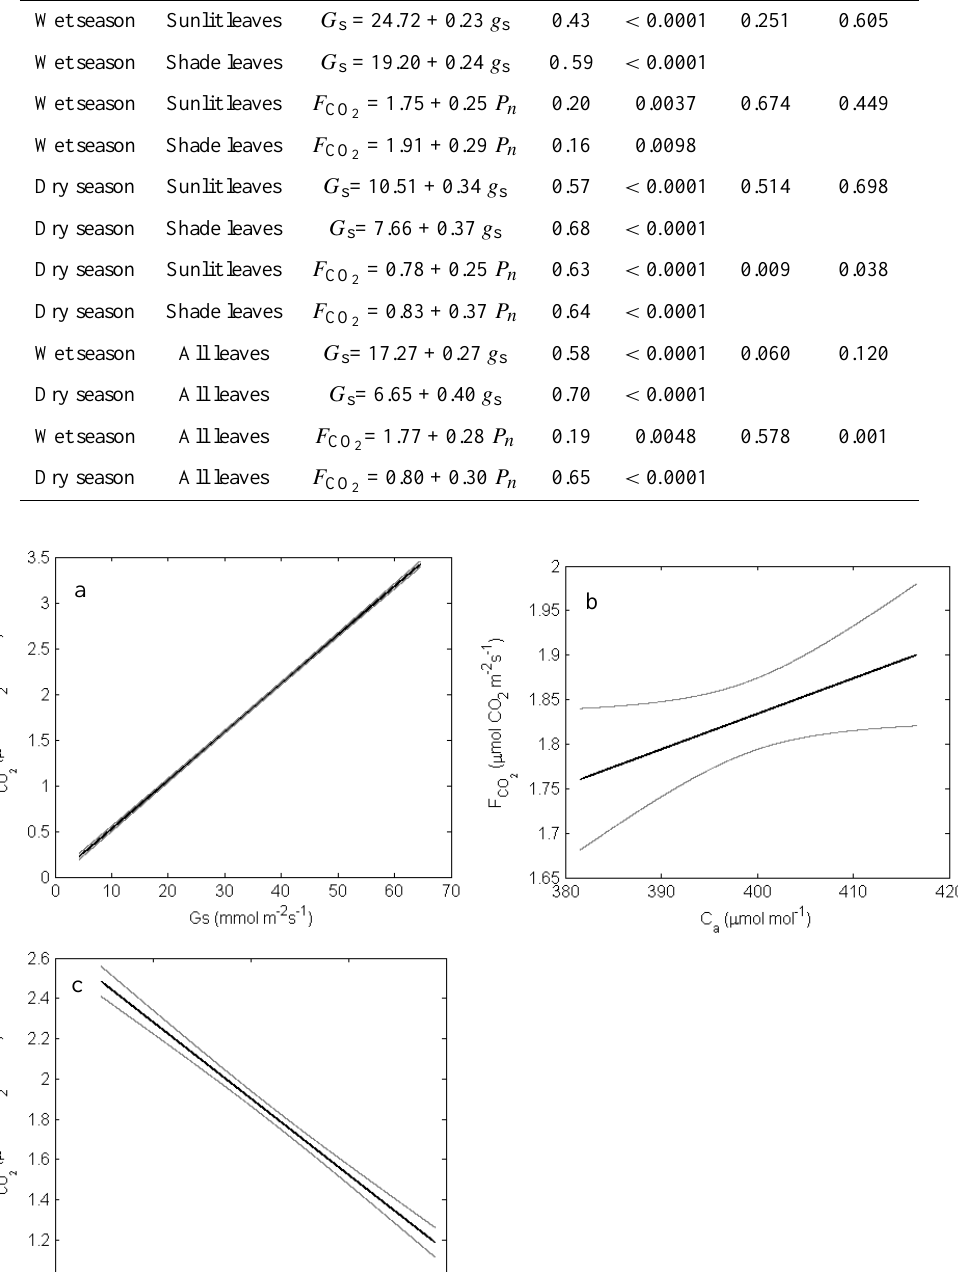
= 0 . 0531 G s – 0.002, ( F CO 2 2 ( F CO = 0.004 C a + 0.239, R 2 = 0 . 0016, 2 2 = − 0 . 3794 1 + 10.2506, R 2 = 0 . 1348, ( F CO 2 2